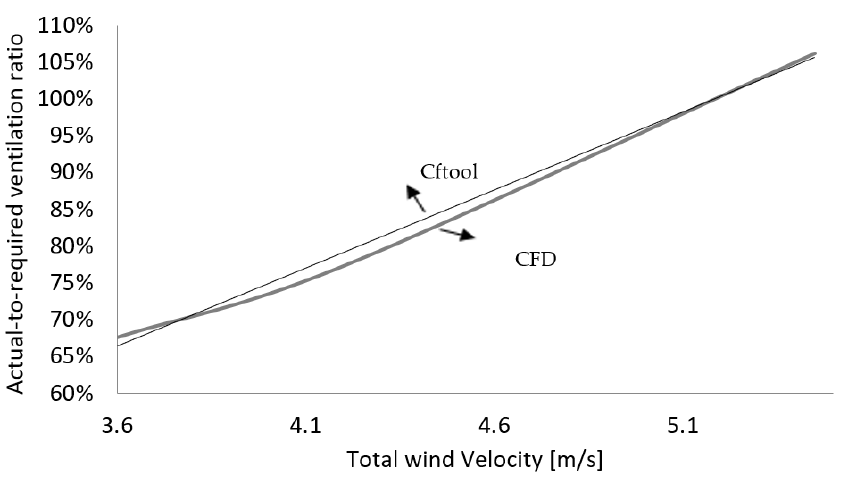
Figure 22. Actual-to-required ventilation with respect to the total wind velocity.